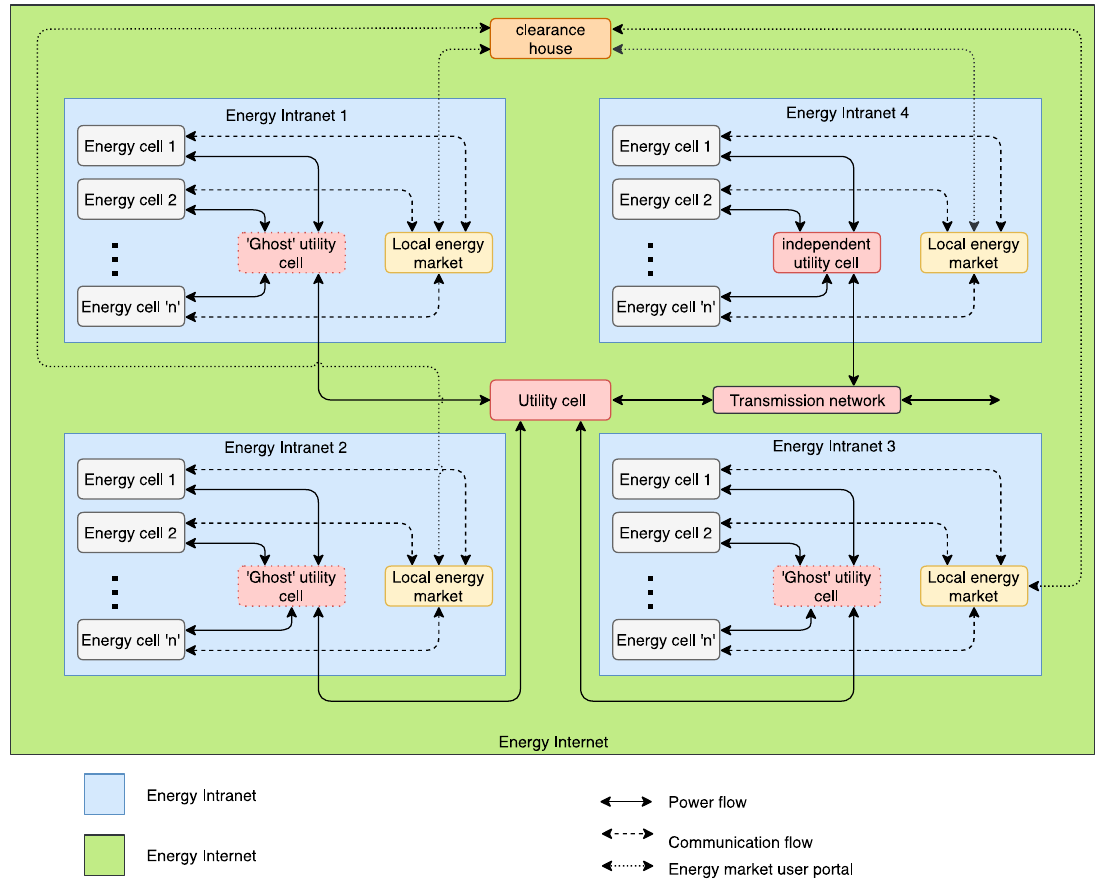
Figure 6. Structure of Energy Internet.